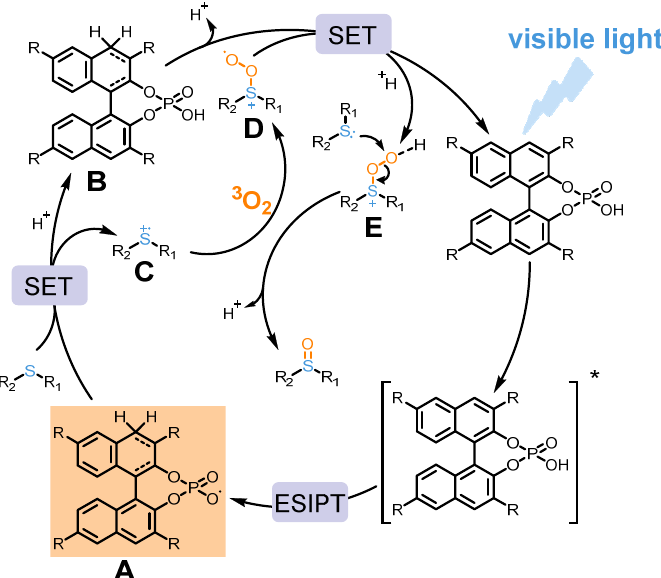
Figure 6. ( a ) EPR spectra of Zr-MOF-P under different conditions. ( b ) EPR spectra of L 1 Me 4 and L 2 Me 4 under different